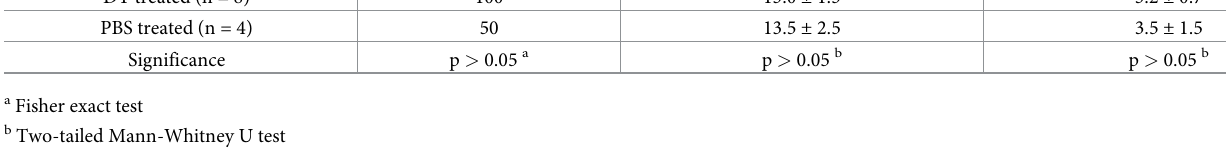
Table 2. PLP-induced EAE in DT treated CD11c-DTR SJL BM chimeras. CD11-cDTR SJL BM